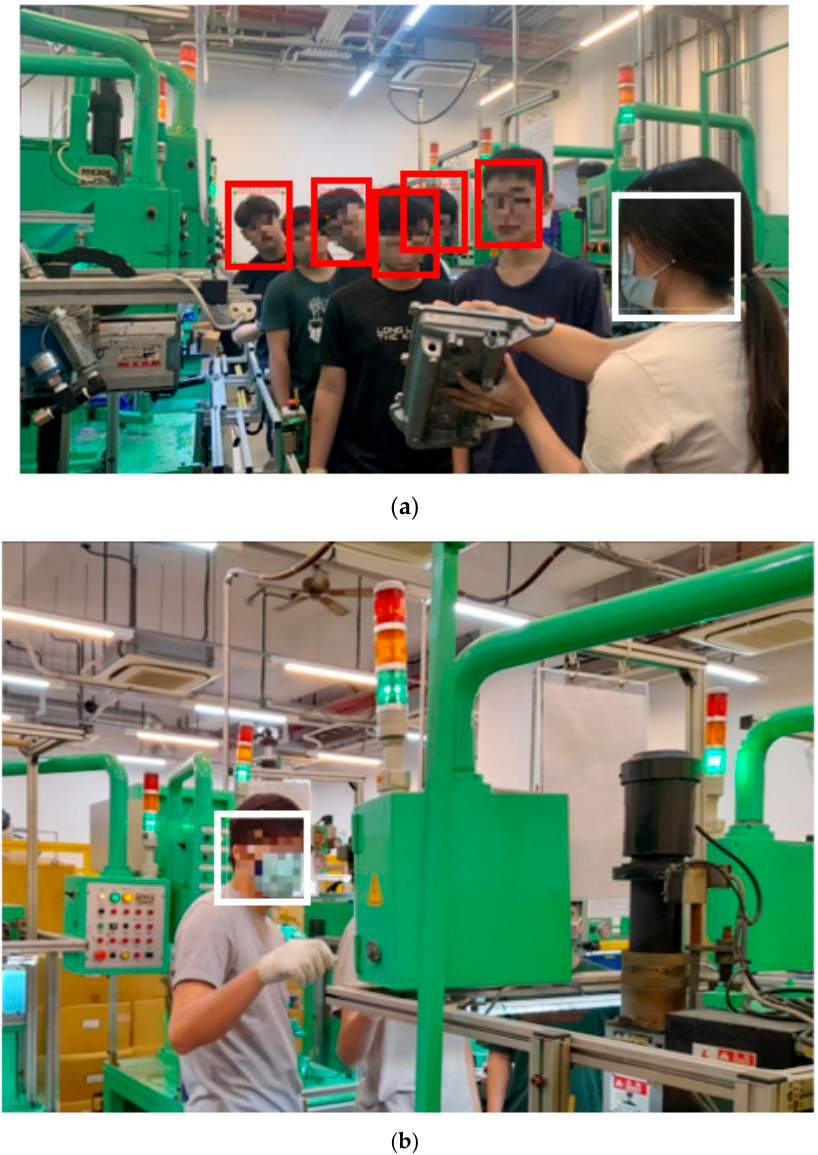
Figure 12. The output of image labeling (The red box line is labeled as an abnormal class/white box line is labeled as a normal class). ( a ) The pictorial diagram- multiple operators (The operators’ faces were pixelated). ( b ) The pictorial diagram- single operator (The operator’s face was pixelated).